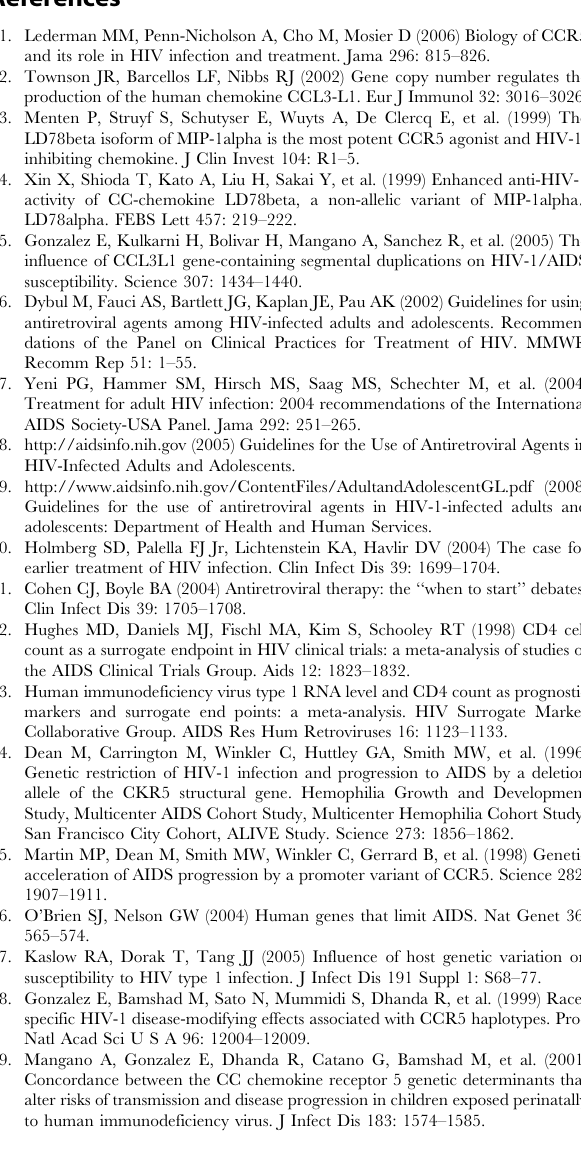
Found at: doi:10.1371/journal.pone.0003165.s004 (0.04 MB